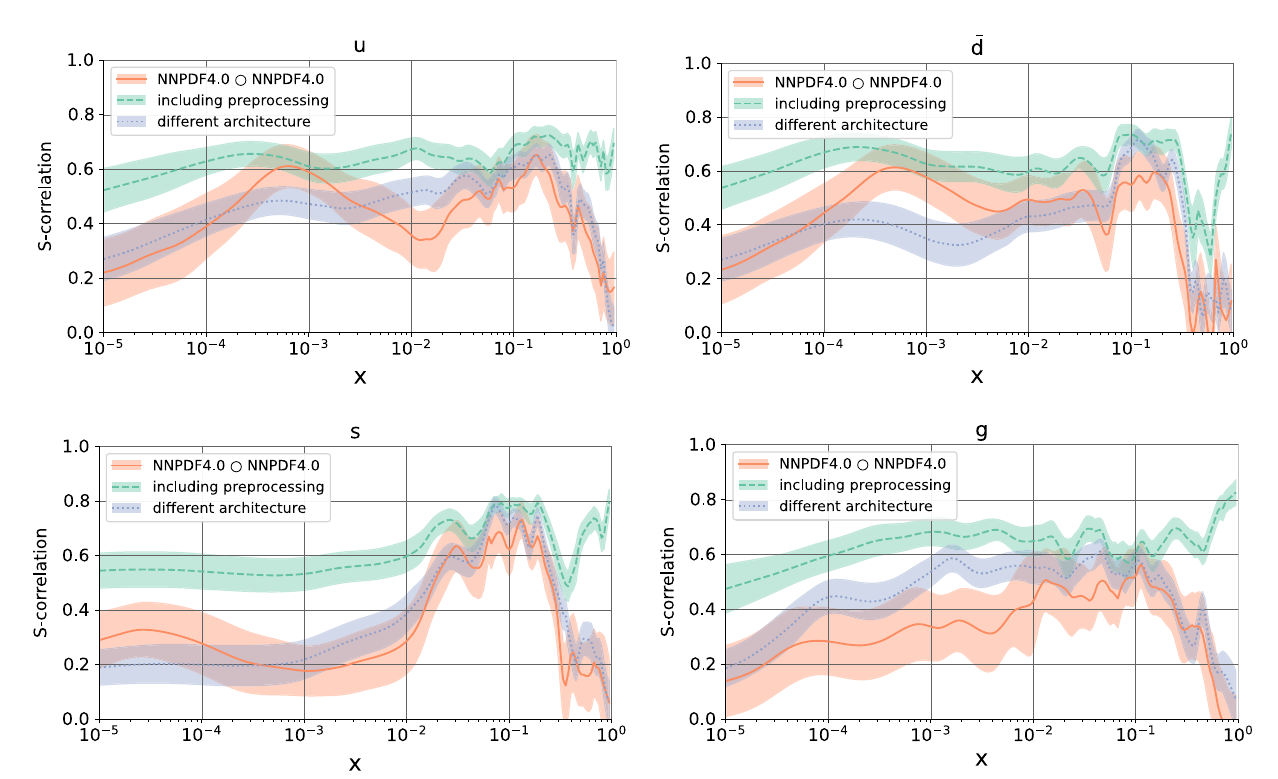
the neural network architecture is changed with all other aspects of the methodology kept fixed (blue). Results are shown for the up, anti-down, strange and gluon